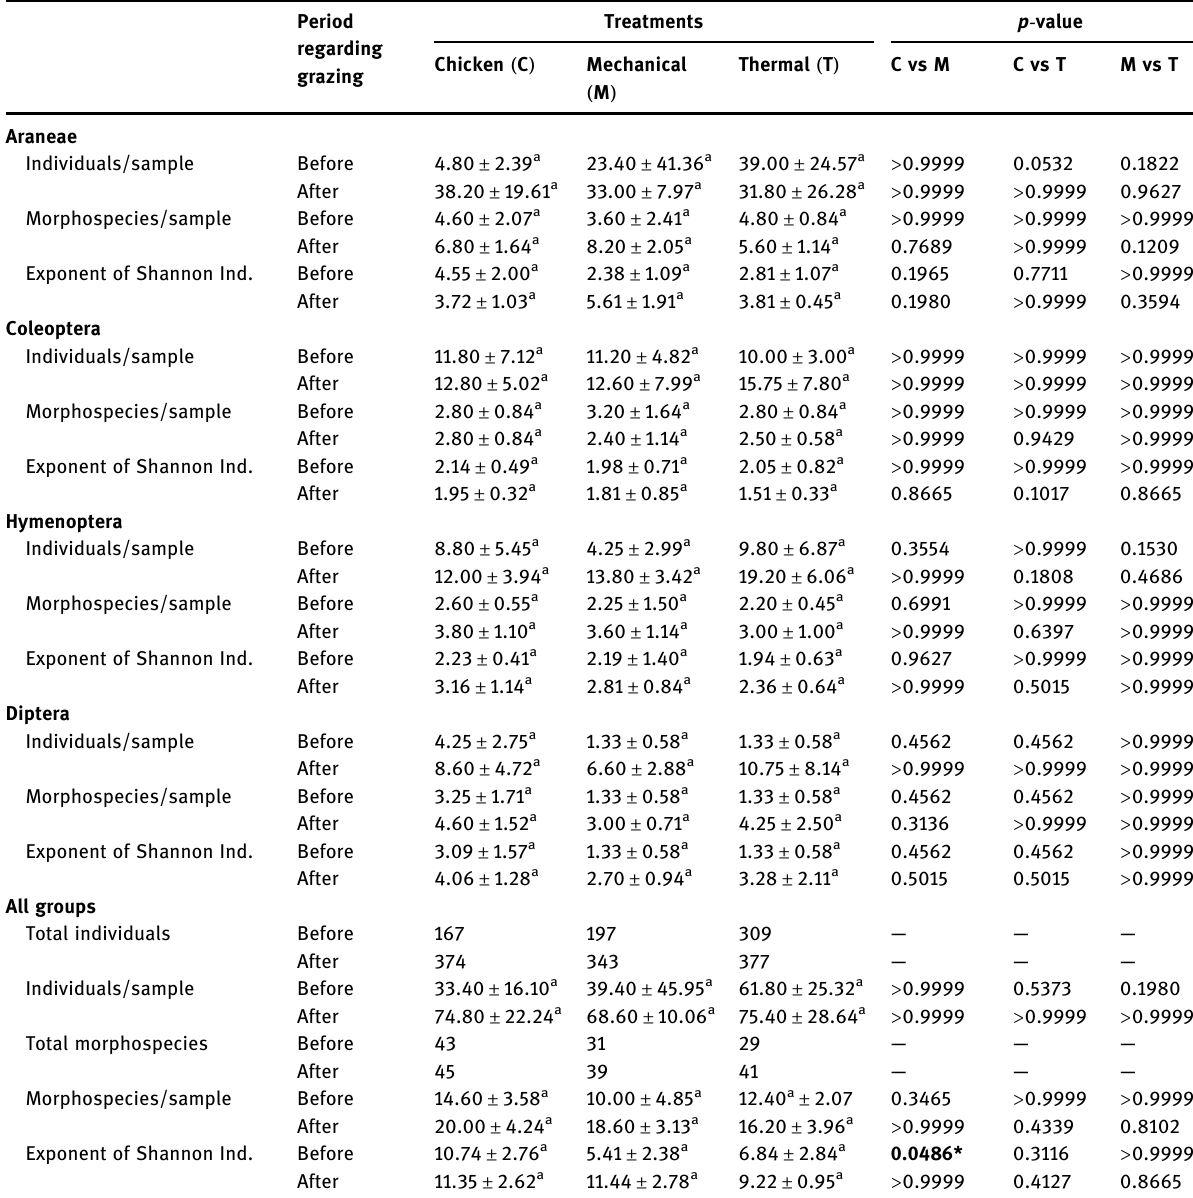
Table 1: Density of soil epigeic macrofauna and diversity ( exponent of Shannon index ) of the dominant groups and all groups at the horticultural fi eld ( mean ± standard deviation